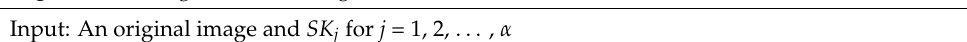
Algorithm 2 Image Protection Algorithm.